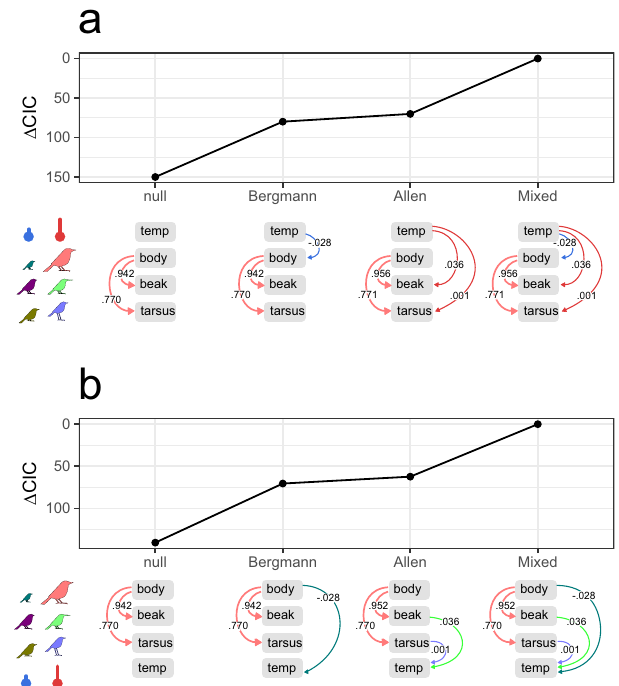
Fig. 5 | Phylogenetic path analysis with responses of the length of avian appendages(beakandtarsus)(a)andthemaximumtemperatureofallmonths within species range (b) across 9962 species (99.7% of global community). In both cases model candidates include different combinations of allometry (rela- tionship between the length of appendages and body size), Bergmann ’ s rule (the relationship between body size and the temperature) and Allen ’ s rule (relationship between the length of appendages and temperature). Δ CIC — delta C statistic InformationCriterion.Theresultswereobtainedwithphylogeneticpathanalysisby using phylopath models on a single maximum clade credibility phylogenetic tree and scaled covariates (mean=0±1SD) to compare their effect sizes (see numbers on path